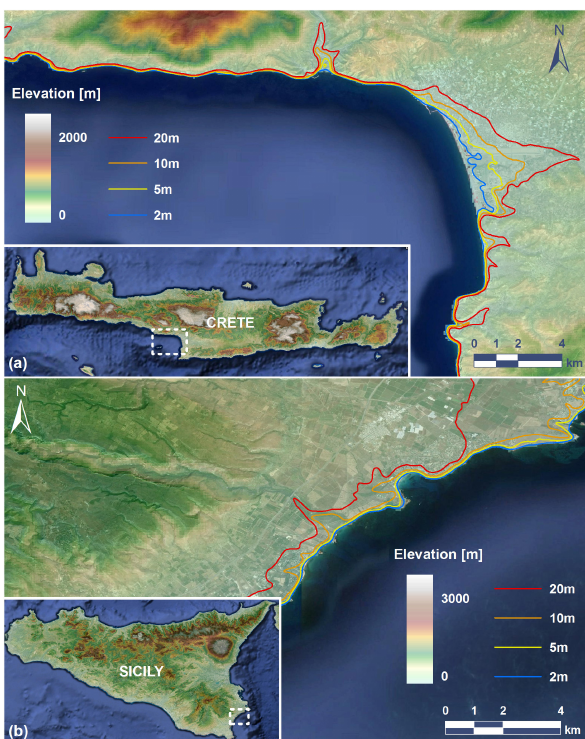
Figure 6. Location, elevation and selected topographic contours for the low-lying coastal areas of interest at: (a) south-southwest Crete, and (b) east-southeast Sicily (base images from Google Earth, 2015; privately processed using NASA SRTM data from USGS/GDE, 2015).